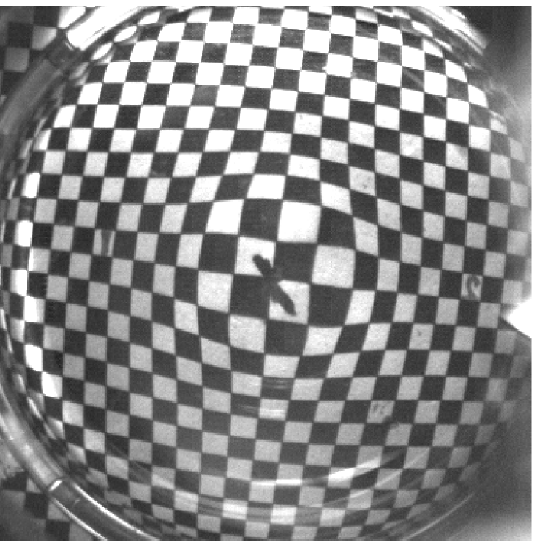
Figure A1. Recorded target image without correction.